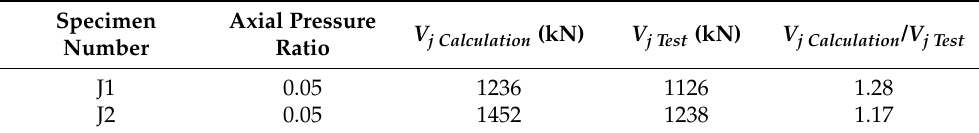
Figure 37. Stress diagram of the joint core. Table 12. Comparison between the calculated values and test values of shear bearing capacity of joints.